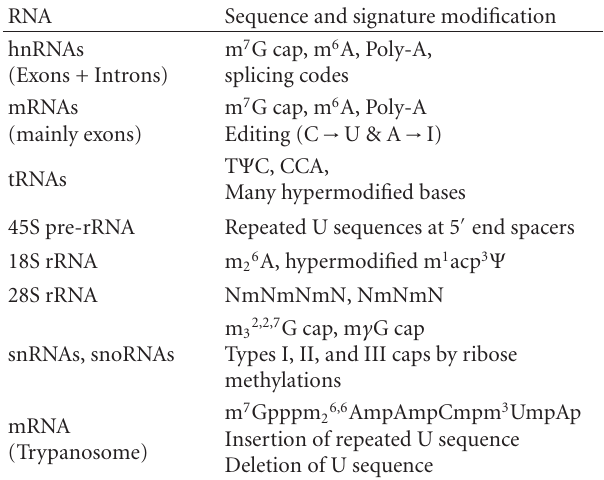
Table 5: Examples of modification. All RNA species including high- and low-molecular-weight RNAs have their own signature sequences and